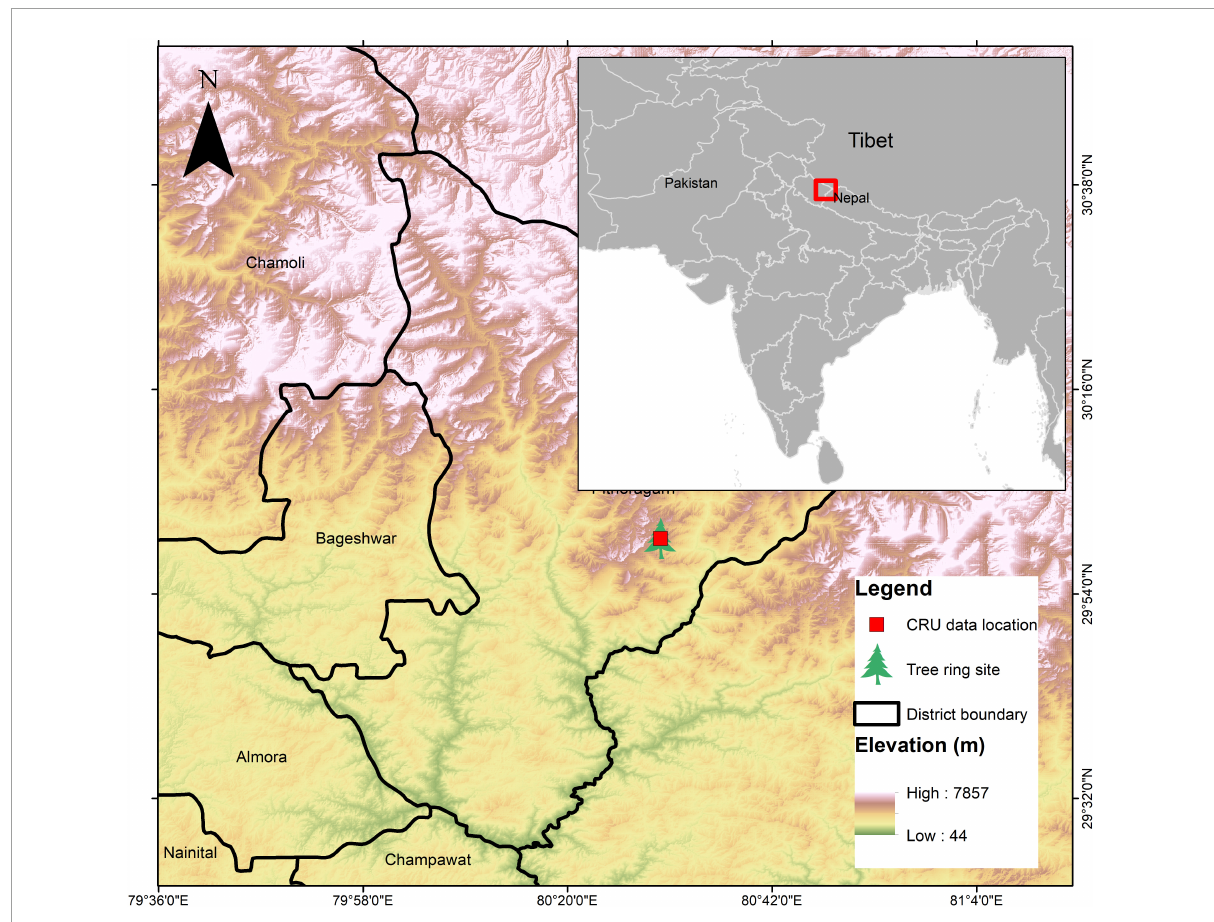
FIGURE1 Map of the study sites showing tree ring sampling locations (green trees) and nearest Climate Research Unit (CRU) grid locations (red